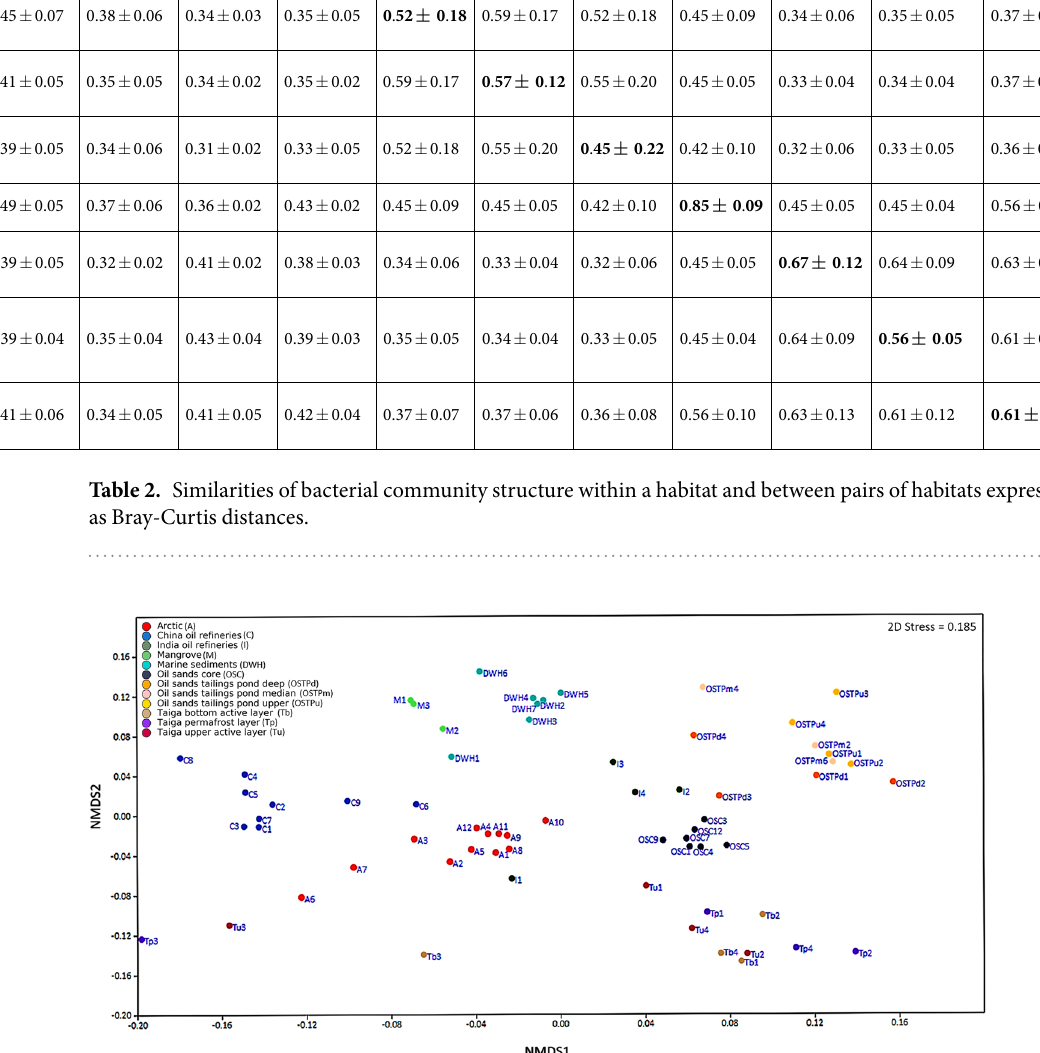
Candidatus Koribacter , Methylobacterium , Caulobacter , and Rhodococcus were attributed as biomarkers for OSTPu, OSTPm, A, C, DWH, I, OSC, Tb, and Tu samples respectively (Supplementary Fig. S2, Supplementary Tables S2 and S5). Pathogenic microorganisms are known to be important degraders of petroleum hydrocarbons. Several strains of infectious microbes such as Burkholderia 32 , Stenotrophomonas 33, 34 and Mycobacterium 35 have been shown to harbor impressive capabilities for degradation of a variety of petroleum hydrocarbons. In the